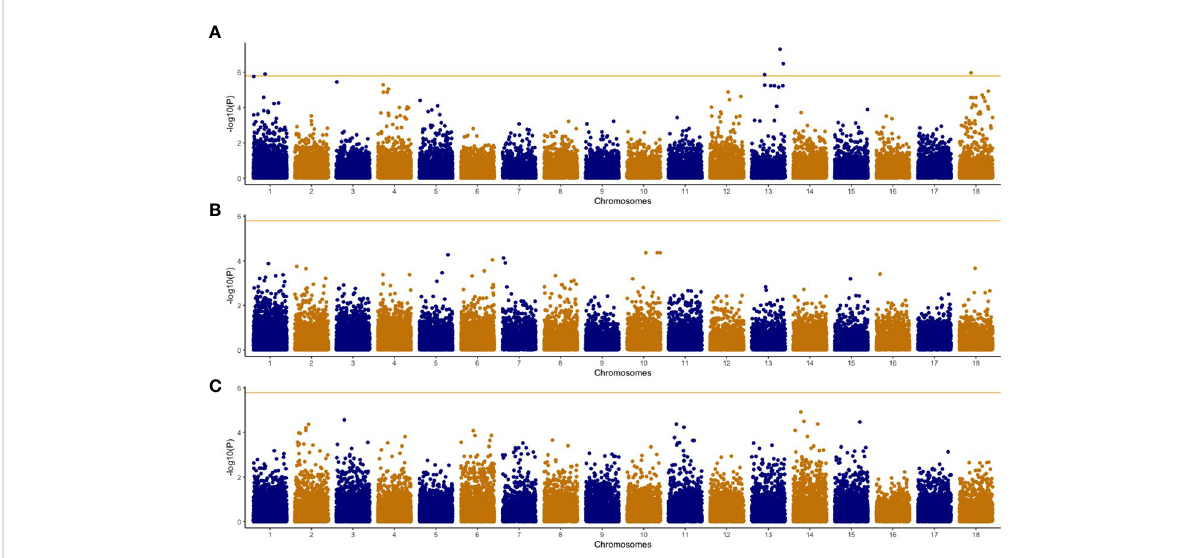
FIGURE 2 Manhattan plots of univariate genome-wide association studies for CBSD severity traits in the C2 population. A = cassava brown streak foliar severity at 3 MAP; B = cassava brown streak foliar severity at 3 MAP; C = cassava brown streak root severity. Orange horizontal line indicates Bonferroni genome wide signi fi cance level [-log 10 (0.05/number of